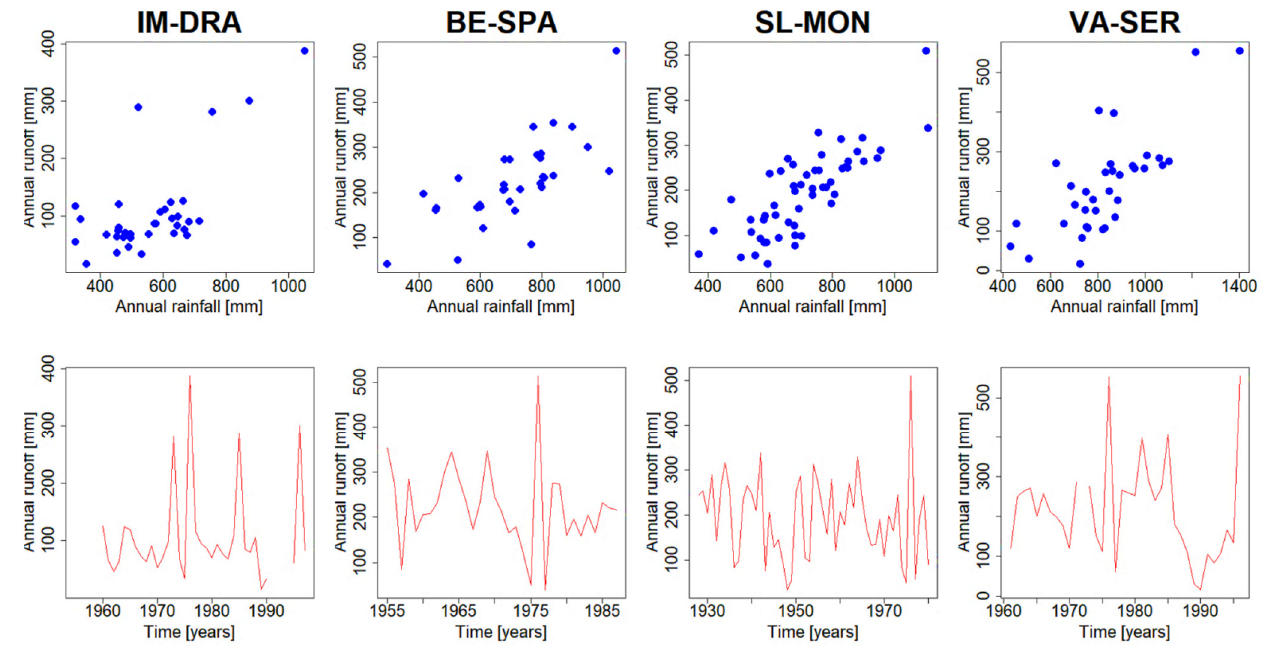
Figure 3. Scatterplots of annual runoff vs. rainfall ( first row ) and annual runoff vs. time ( second row ) for IM-DRA, BE-SPA, SL-MON and